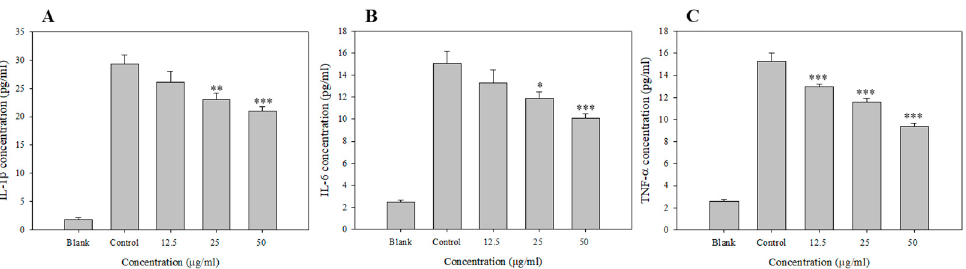
Figure 2. Inhibition of LPS induced IL-1b, IL-6 and TNF-a in the EAF. RAW 264.7 cells were preincubated with 12.5 or 25 μ g/mL of EAF for 1 h and then treated with 1 μ g/mL of LPS for 24 h. The IL-1 β , IL-6, and TNF- α production was measured by ELISA, as described in Materials and Methods. Data are represented as means ± SEMs. * Statistical significance of the di ff erence between LPS and LPS + sample treatment groups: * p < 0.05, ** p < 0.01, *** p <